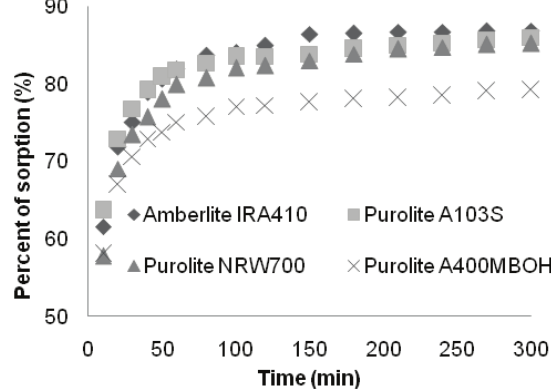
Figure 1. Removal efficiency for zinc sorption on different anion exchangers; C